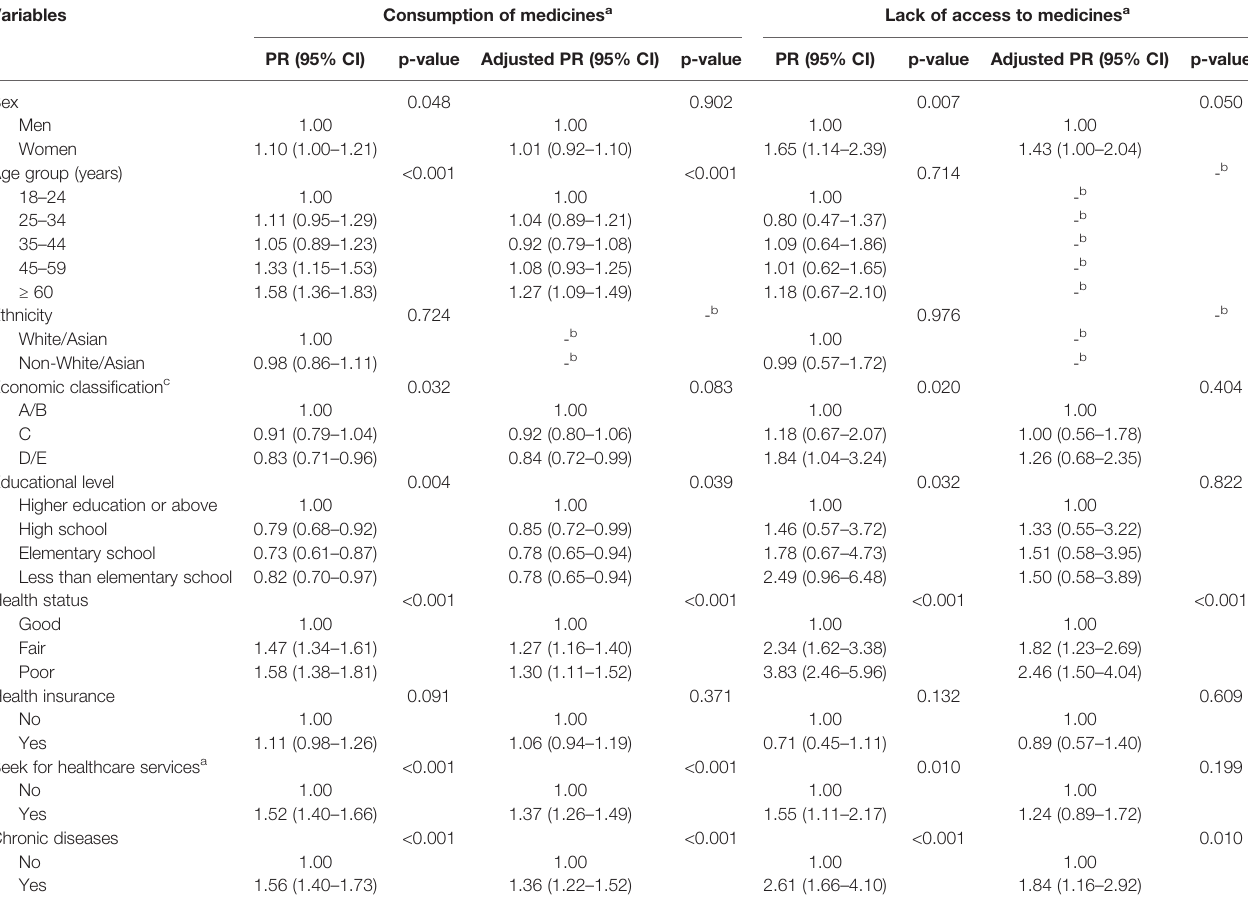
TABLE 4 | Unadjusted and adjusted prevalence ratios (PRs) and 95% con fi dence intervals (CIs) of consumption and lack of access to medicines in Manaus, 2019 (N=2,321).